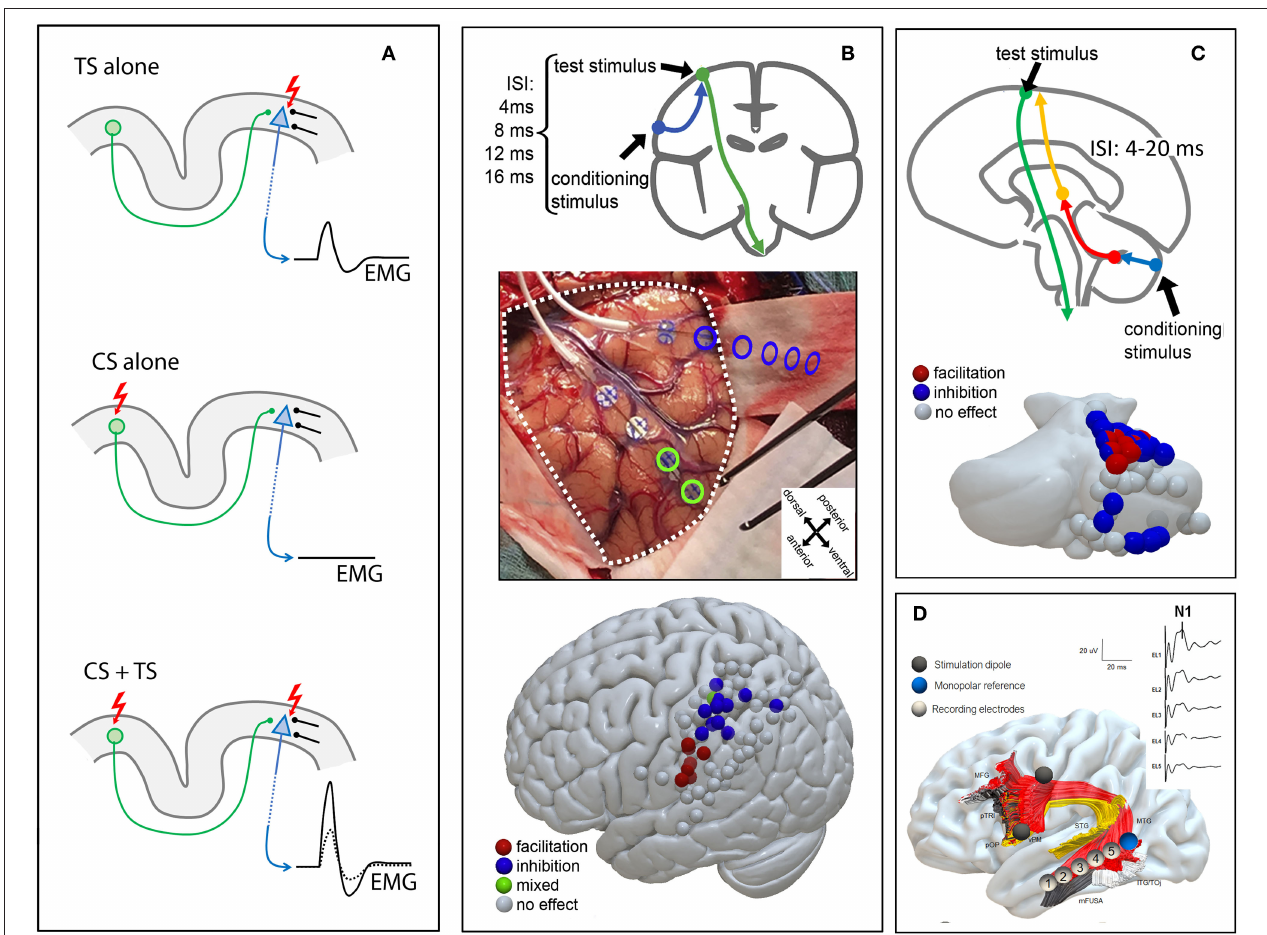
FIGURE 1 | Schematic CS/TS and ccEP paradigms. (A) Upper panel TS stimulation alone induces an MEP; middle panel CS stimulation alone does not evoke an MEP; lower panel combined CS + TS stimulation leads to increased MEP amplitude. CS, conditioning stimulus; TS, test stimulus (B) Parieto-motor stimulation protocol: a CS stimulus is applied over the posterior parietal cortex from 4 to 16ms before a TS on M1. A dorso-ventral posterior parietal distinction between MEP inhibition (dorsal) and MEP facilitation (ventral) is shown. The picture is modified from (15) with permission CS, conditioning stimulus; TS, test stimulus (C) Cerebello-motor stimulation protocol: direct cerebellar precedes transcranial electrical stimulation with an inter-stimulus interval (ISI) of 4–20ms, causing MEP inhibition (blue) or facilitation (red). (D) ccEPs for the arcuate fasciculus: strip electrodes are placed intraoperatively at cortical termination of the arcuate fasciculus after preoperative testing. ccEPs are recorded from the middle temporal cortical termination of the arcuate fasciculus (shown on the right side). Segments of the arcuate fasciculus are dissected according to cortical termination (19). MFG, middle frontal gyrus; pTRI, pars triangularis; pOP, pars opercularis; vPM, ventral premotor cortex; STG, superior temporal gyrus; MTG, middle temporal gyrus; ITG, inferior temporal gyrus; TOj, temporo-occipital junction; mFUSA, middle fusiform gyrus